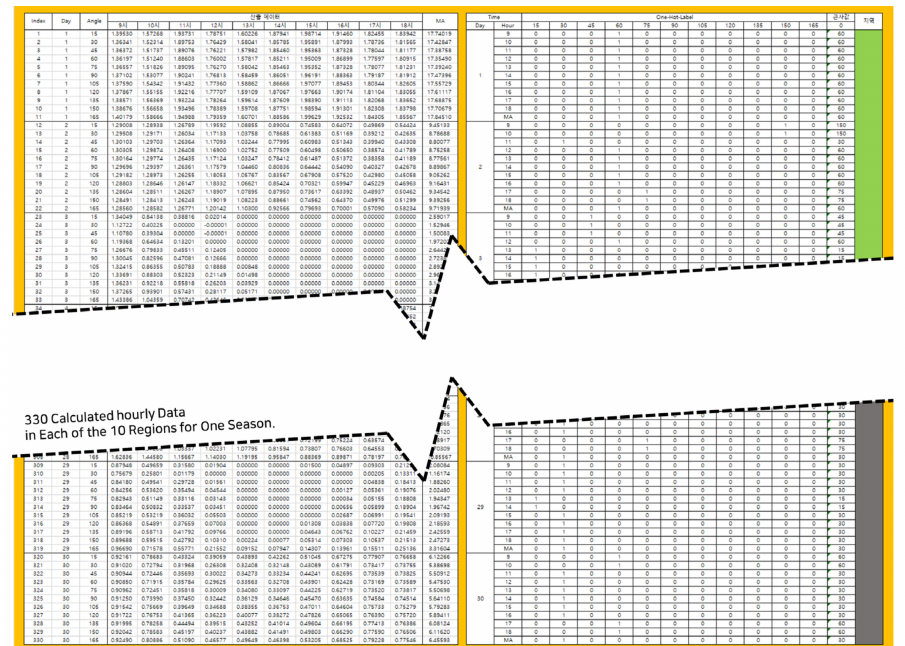
Figure 6. Thermal load balance data sheet.